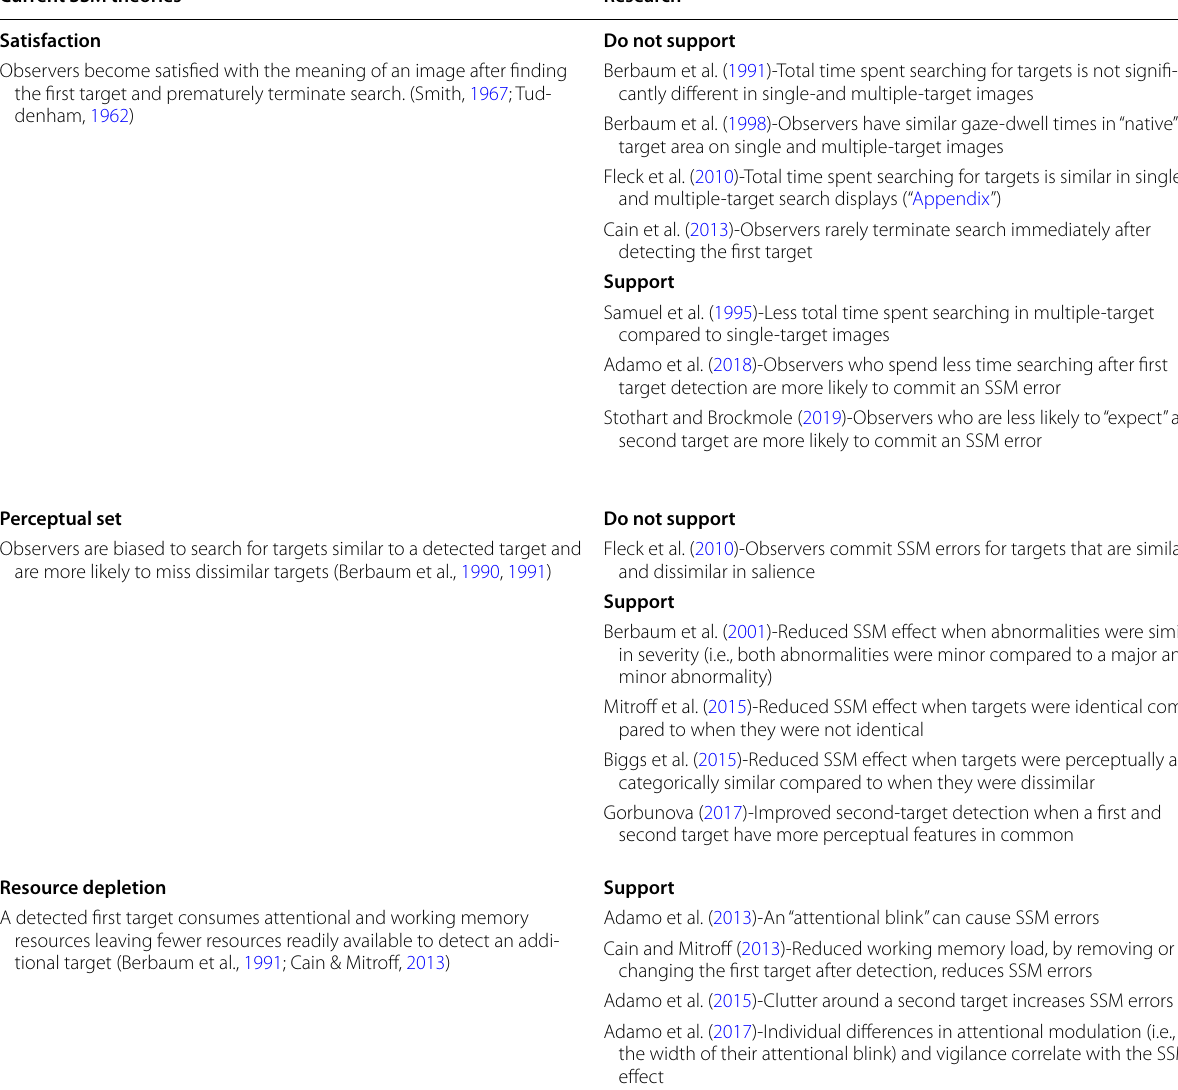
Table 1 Summary of SSM Theories and Their Respective Research Current SSM theories Research